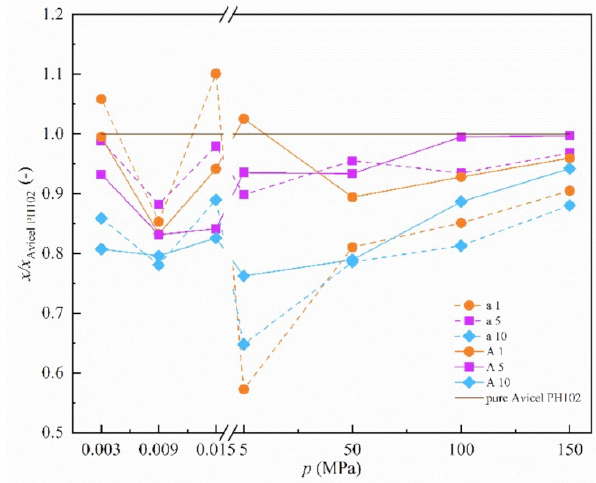
Materials 2021 , 14 , x 12 of 15 Figure 4. Effect of applied pressure on mixture containing Neusilin ® S2. Samples are identified by X-Y abbreviation where X = A-the coarse fraction of microcrystalline cellulose (—), X = a-the finer fraction of microcrystalline cellulose (- - -), Y = 1, 5 and 10—1% ( ● ), 5% ( █ ) and 10% ( ◆ ) of Neusi- fraction of microcrystalline cellulose (- - -), Y = 1, 5 and 10—1% ( • ), 5% ( (cid:4) ) and 10% ( lin ® S2. The x/x Avicel PH102 means the ratio of the value measured for mixture to the value measured for pure microcrystalline cellulose. The x means effective angle of internal friction for applied pressure up to 15 kPa and tensile strength for remaining applied pressures. (Standard deviation is not presented due to the graph readability). Table 5. Tensile strength of tablets compacted from pure compounds.